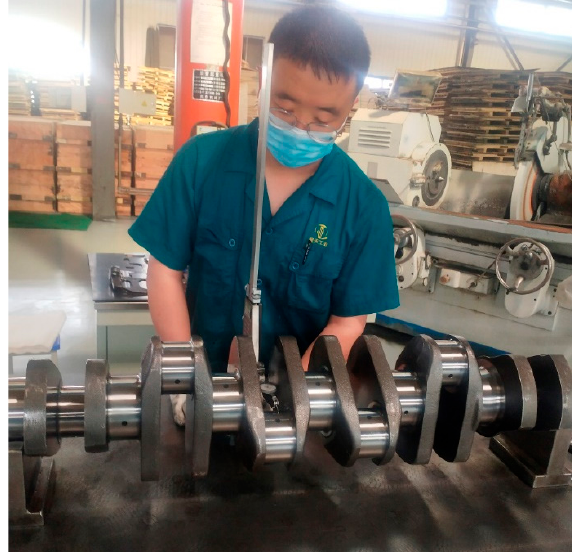
Figure 1. Manual measurement of crankshaft parameters.